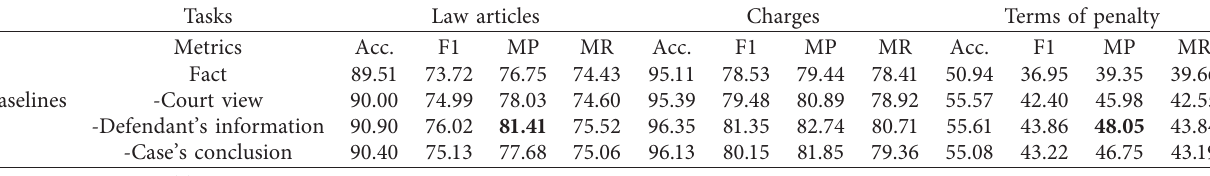
Table 8: Comparable results of the effect of different information sources in the model.